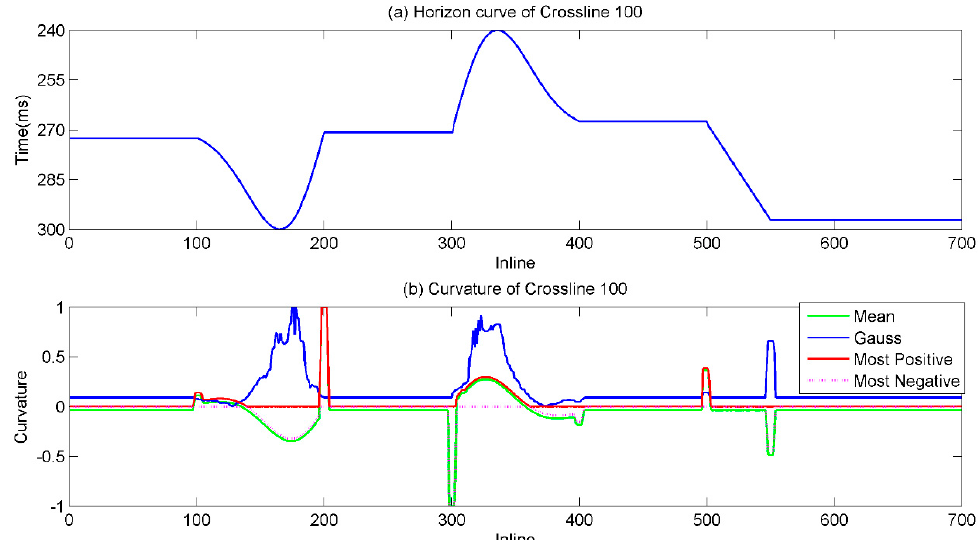
Figure 11. Horizon curve and curvature attributes without noise: ( a ) Horizon curve and ( b ) curvature attributes without noise.